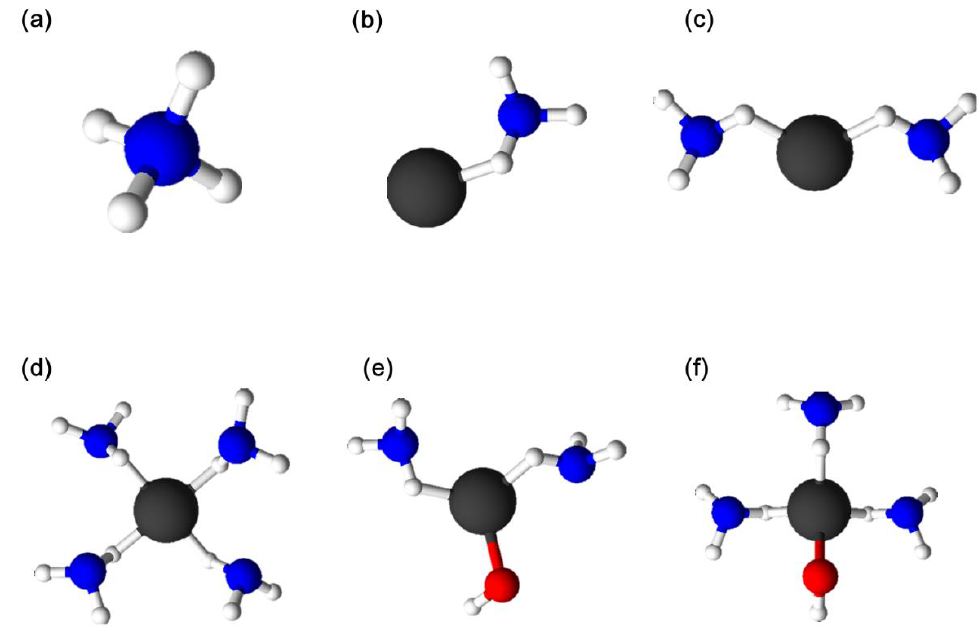
Figure 1. Atomic configurations of NH 3 complexes adsorbed in Cu-SSZ-13 zeolite as NH 3 molecules. ( a ) NH 4+ , ( b ) [Cu(I)NH 3 ] + , ( c ) linear [Cu(I)(NH 3 ) 2 ] + , ( d ) fourfold [Cu(II)(NH 3 ) 4 ] 2+ , ( e ) [Cu(II)(OH)(NH 3 ) 2 ] + , and ( f ) [Cu(II)(OH)(NH 3 ) 3 ] + . Atom color codes: copper (gray), nitrogen (blue), oxygen (red), and hydrogen (white) [5].